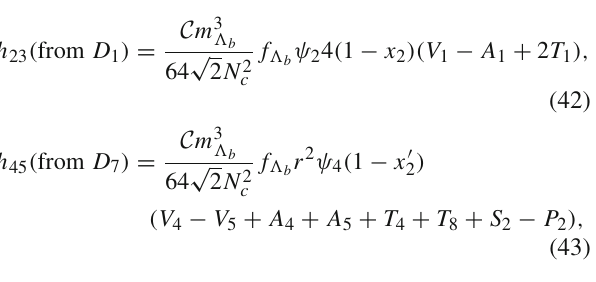
those from light-LCSR- A , light-LCSR- P and lattice QCD hints that the PQCD approach is an effective framework for analyzing exclusive heavy baryon decays, once the higher- twist contributions are taken into account.